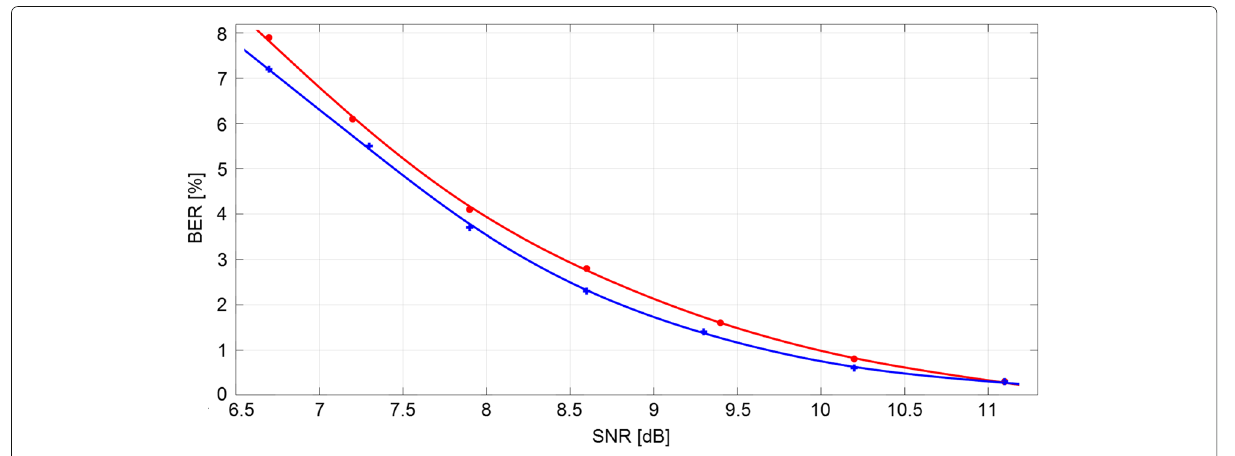
Fig. 3 Perfect reconstruction process: BER vs.